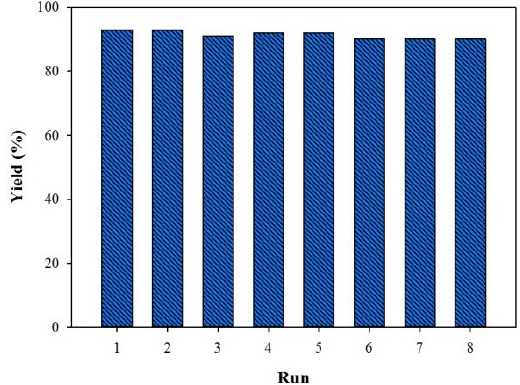
Fig. 6. Reusability of the MNP/HPG-CA/Pd catalyst in the Sonogashira reaction of iodobenzene, phenylacetylen. without a significant loss of activity (Fig. 6).